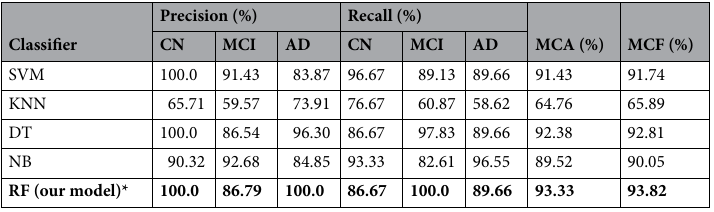
Table 6. Comparison of different classifiers ( MS 2 test dataset ; First Layer). MCA: multiclass classification accuracy, MCF: multiclass F1 score; Asterisk ( *): is the model with the best predictive performance.